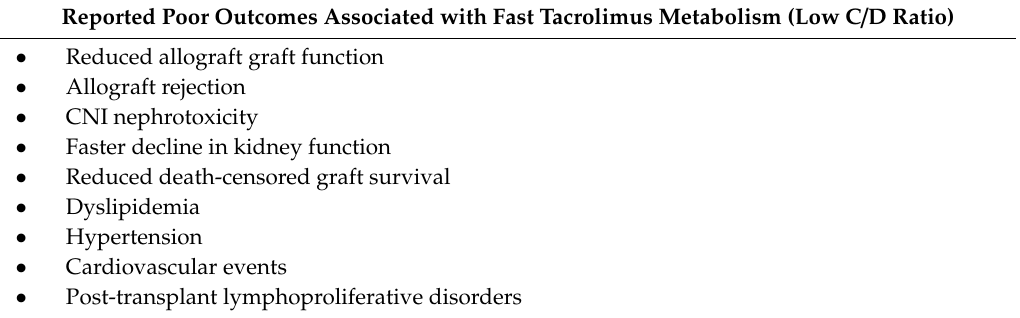
Table 3. Poor outcomes associated with fast tacrolimus metabolism (low C / D